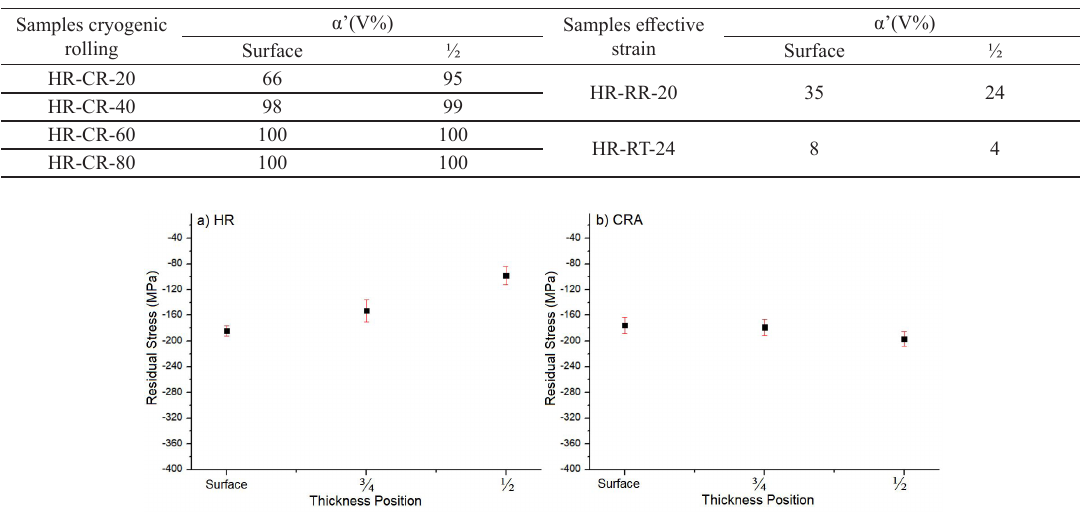
Figure 2. Residual stress profiles of the austenite phase as function thickness position HR (a) and CRA (b) samples.